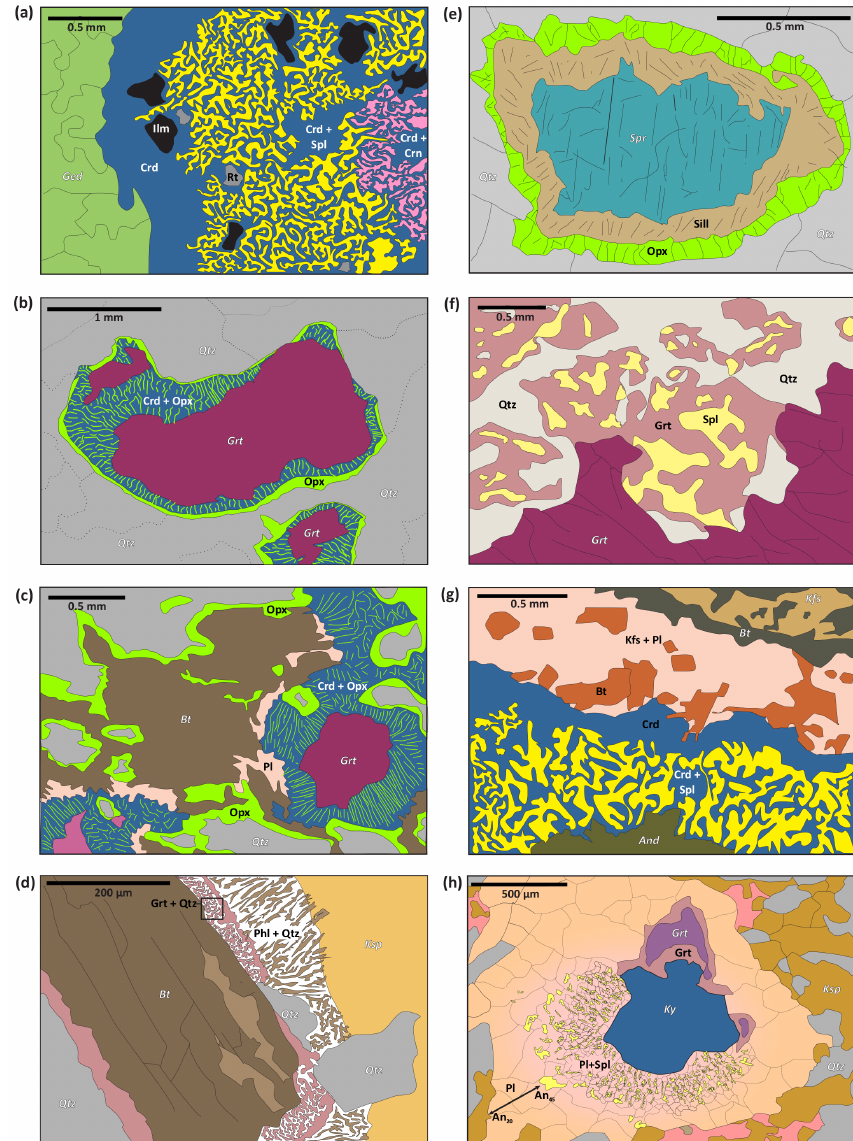
Figure 8. Sectoral complexity in corona textures developed in pelitic granulites. (a) Complex corona between kyanite and gedrite (after Norlander et al., 2002). No compositional variation in any corona phases was observed. Conditions of formation constrained at <5kbar and ∼ 750 ◦ C with TWQ and conventional thermobarometers. (b) Common complex corona developed after garnet and quartz (after Hollis et al., 2006). No systematic variation is described in corona products. (c) Complex sectoral corona between garnet, biotite and quartz. Monomineralic plagioclase is constrained to the corona immediately adjacent to biotite. Similarly, blocky orthopyroxene occurs only in the corona sectors where garnet reacts with quartz (after Kelsey et al., 2003). Cordierite X Mg varies across symplectite increasing toward orthopyroxene in general. No variation in orthopyroxene composition is observed. (d) Symplectite-dominated corona developed between biotite and K-feldspar (after Bruno et al., 2001). Where biotite reacts with quartz, monomineralic garnet comprises the corona. Elsewhere, a complex, symplectite-dominated corona comprising garnet, quartz and phlogopite occurs where biotite and feldspar react. Corona garnet is weakly zoned. (e) Monomineralic sillimanite and orthopyroxene developed after sapphirine and quartz (after Ellis, 1980, and Grew, 1980). (f) Retrograde spinel–garnet symplectite replacing peak garnet during post-peak decompression (after White et al., 2002). This corona develops in response to changing modes in a high-variance equilibrium assemblage. No univariant reaction is crossed. (g) Prograde complex corona comprising spinel–cordierite symplectite and leucocratic biotite, K-feldspar and plagioclase after andalusite (after Johnson et al., 2004). X Mg of cordierite decreases toward biotite (0.55–0.51) with no variation in spinel composition. Cordierite moat formation occurs during an andalusite melting reaction consuming quartz and biotite, followed by continued breakdown of andalusite to cordierite–spinel symplectite in SiO 2 deficient domains. (h) Sectoral replacement of kyanite by plagioclase + spinel symplectite and zoned monomineralic plagioclase. Where primary garnet abuts kyanite, the symplectite is not developed, and kyanite is replaced by low-Ca garnet enclosed by unzoned plagioclase (After Štípská et al.,